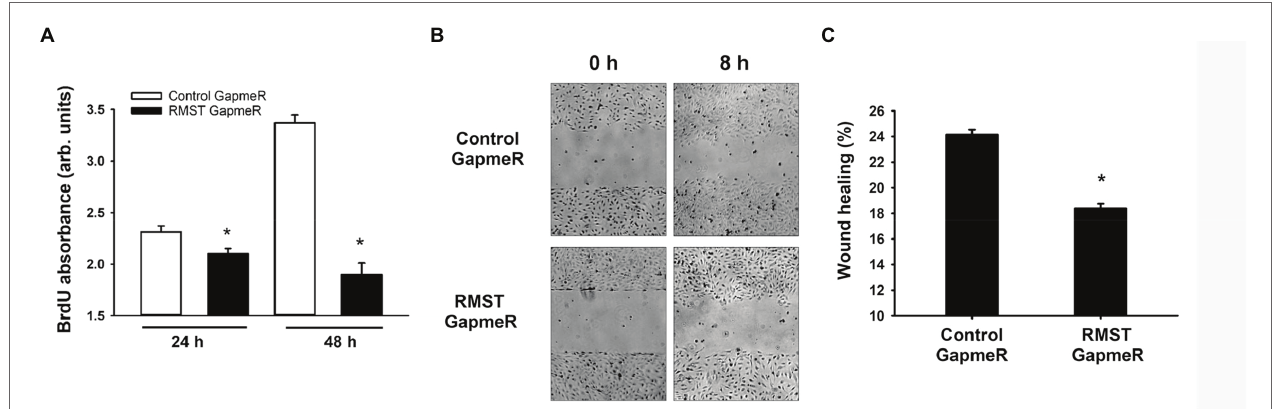
FIGURE 4 | RMST regulation of endothelial cell proliferation and migration. (A) BrdU absorbance of equal numbers of control or RMST GapmeR-transfected HUVECs maintained in complete medium containing BrdU for 24 and 48 h. Values are means ± SEM, expressed in arbitrary units. * p < 0.05, compared to control GapmeR. (B) Representative micrographs of scratch wound healing at times 0 and 8 h in control or RMST GapmeR-transfected HUVECs maintained in basic medium. (C) Percent wound healing in control or RMST GapmeR-transfected HUVECs maintained in basic medium. Values are means ± SEM. * p < 0.05, compared to control GapmeR. N =